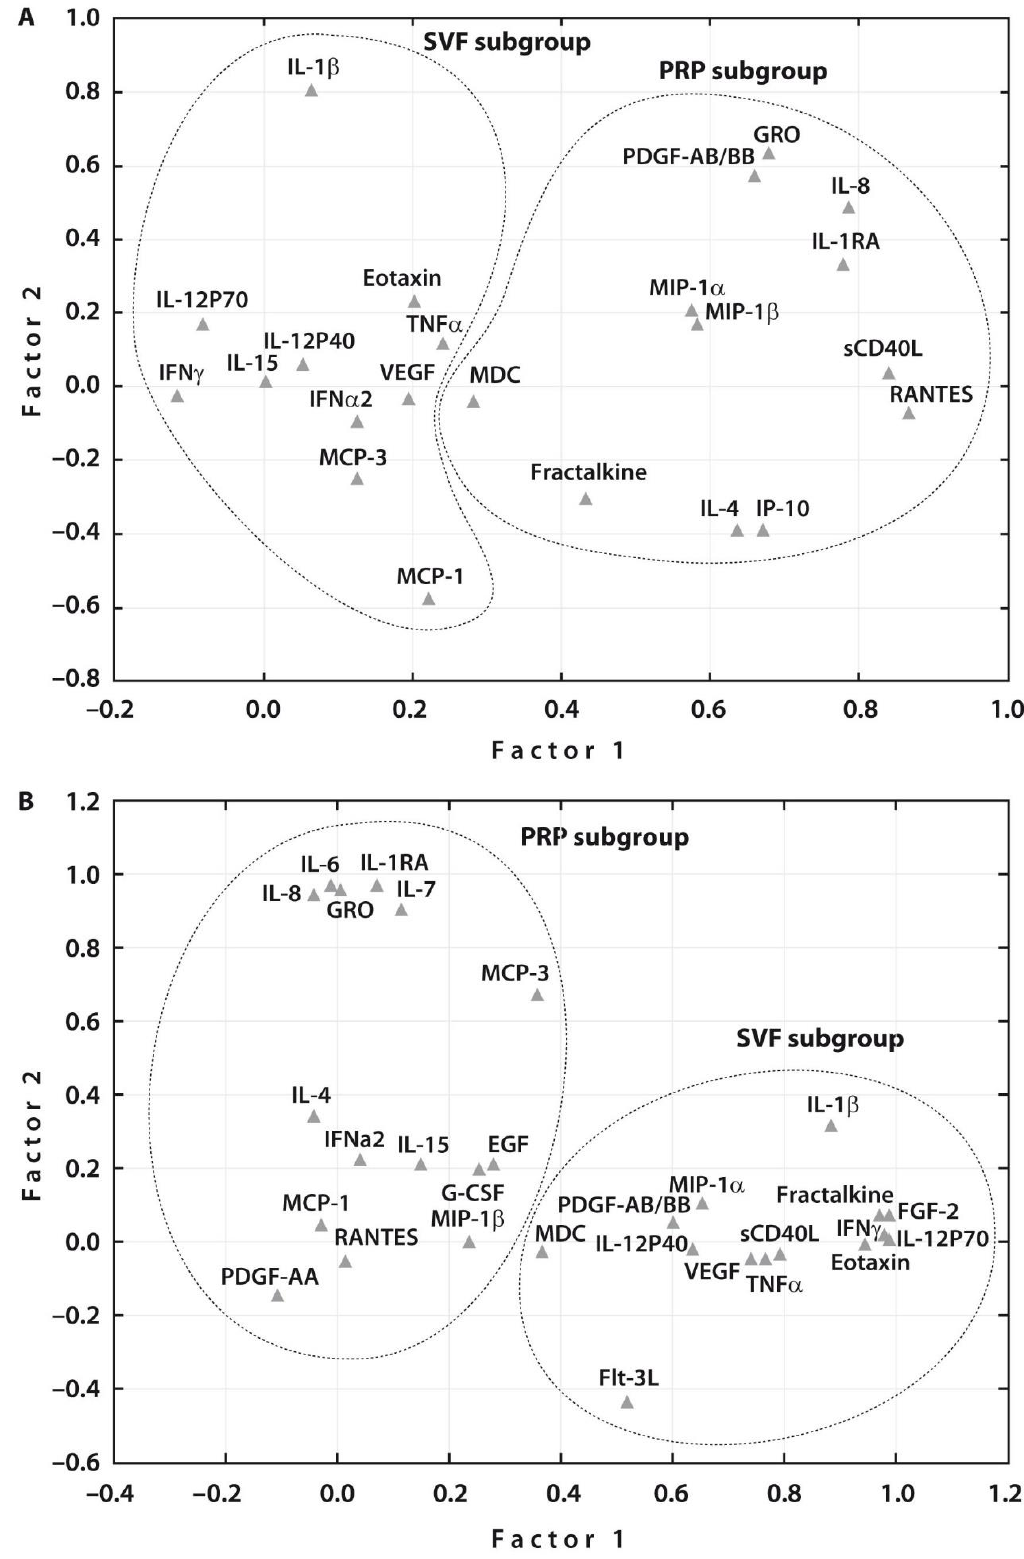
Figure 2. Subgroups of investigated cytokines ( n = 31) after principal component analysis. ( A ) The factor analysis suggested two main factors, one containing 11 (SVF subgroup) and another 12 (PRP subgroup) cytokines analyzed before treatment; and ( B ) two main factors, one containing 14 (SVF subgroup) and another 15 (PRP subgroup) cytokines analyzed one week after